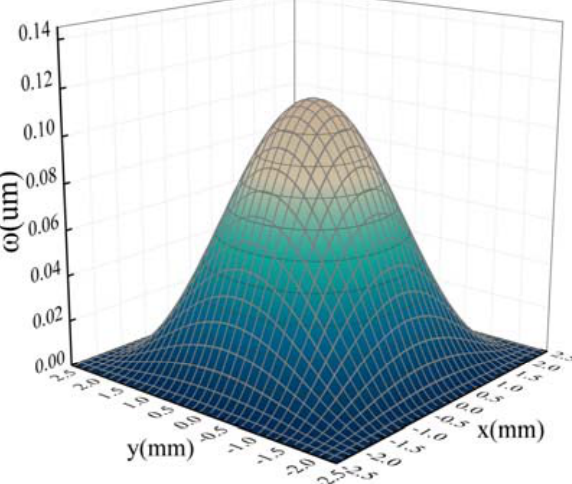
Figure 2. The deflection of the thin membrane.